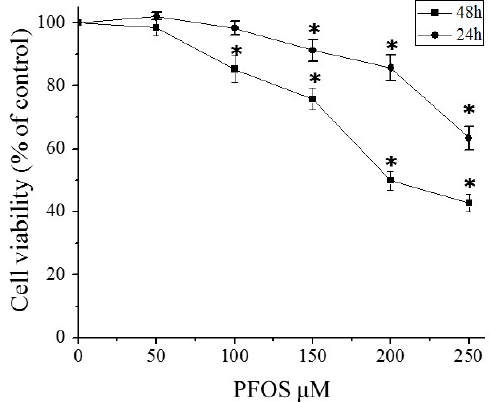
Figure 2. Effects of PFOS on SK-N-SH cell viability. Cell viability was determined by MTT assay after 24 or 48-h exposure to various concentrations of PFOS (50, 100, 150, 200, 250 μ M) or DMSO (control). Data are presented as mean ± SD of three separate experiments. * Compared with control, respectively: p < 0.05.